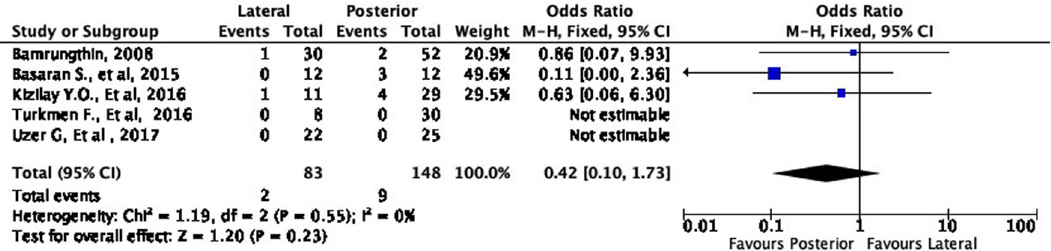
Figure 7. Comparison of functional outcome in the poor subgroup.